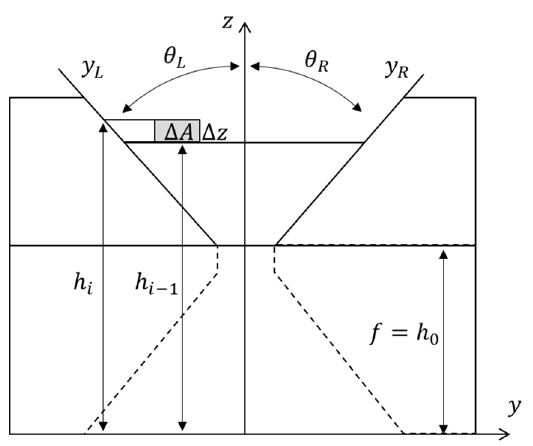
Figure 13. Geometry of X-groove butt welding joint.